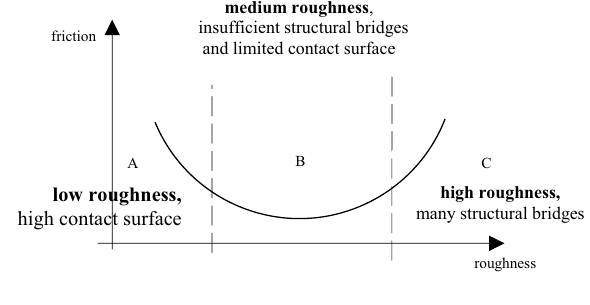
Fig. 1 Roughness-friction force